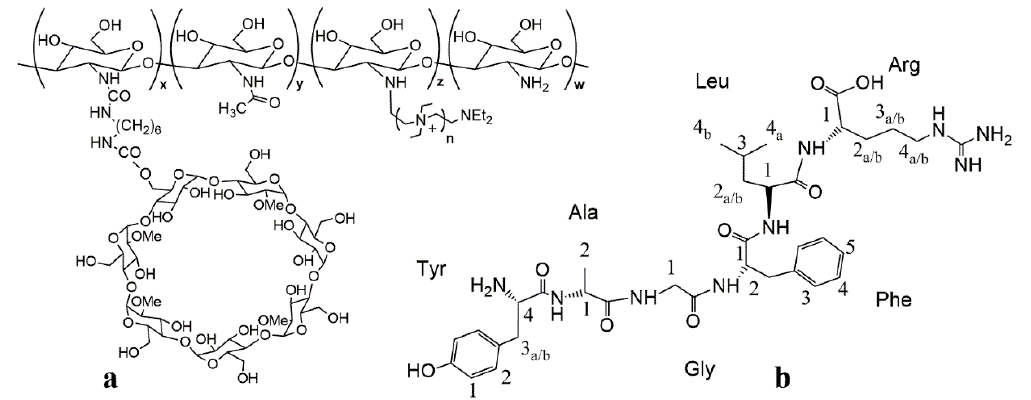
Figure 1. ( a ) 2-methyl-β-cyclodextrin conjugates of ammonium chitosan (N + -rCh-MCD) and ( b ) dalargin